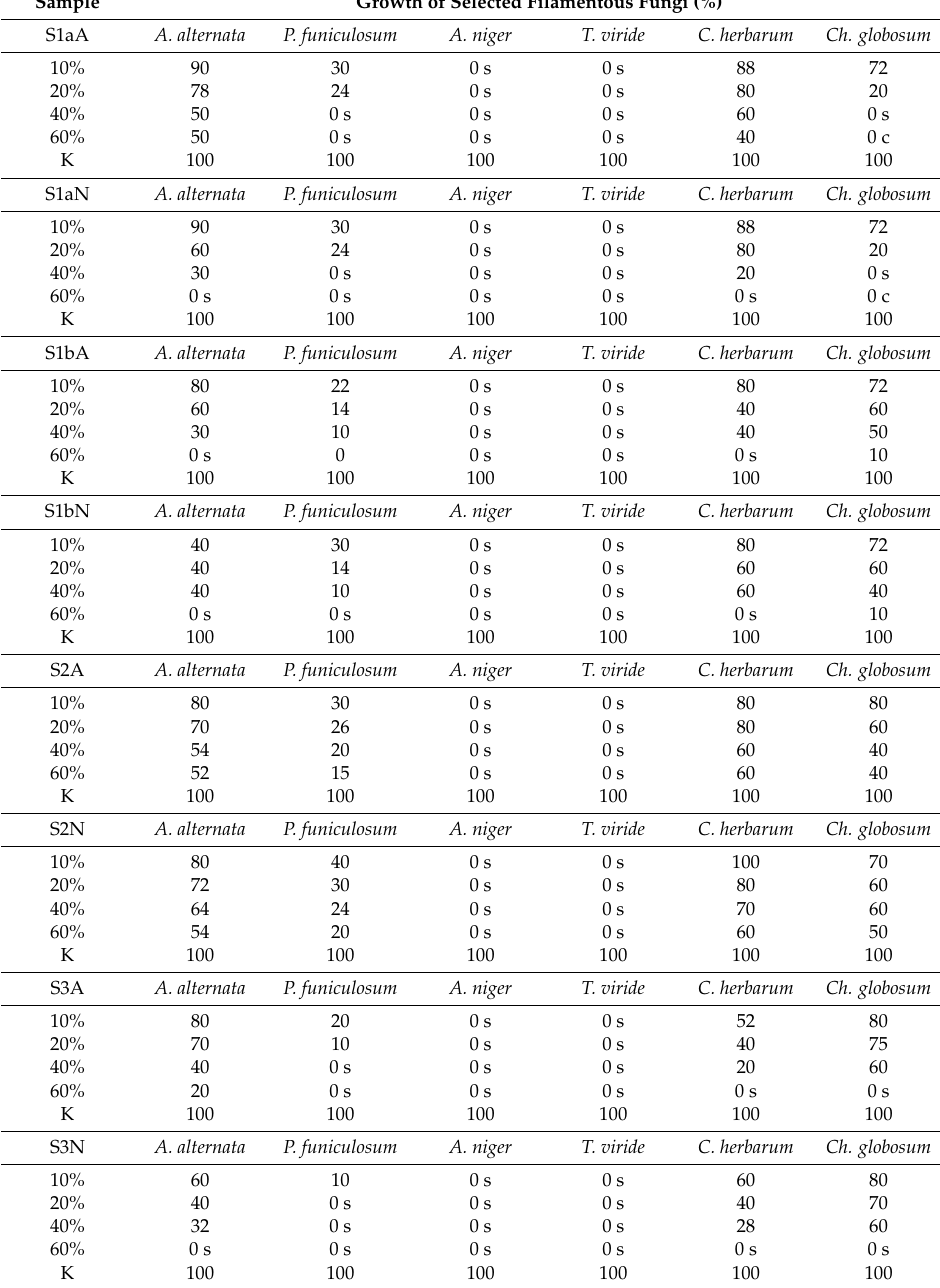
Table 5. Antifungal efficiency of metallurgical slags regarding inhibition of growth of selected filamentous